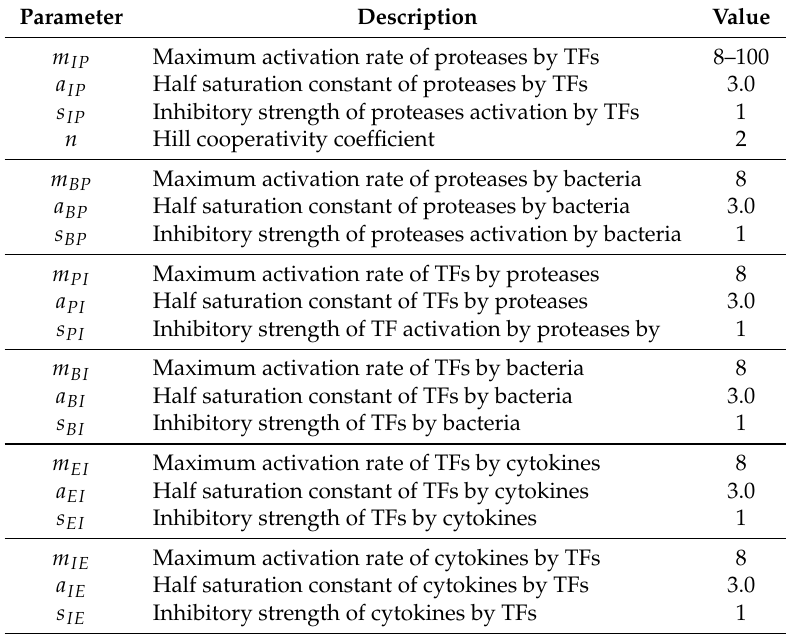
Table 1. Dimensionless parameter values in the M1 model. TF = transcription